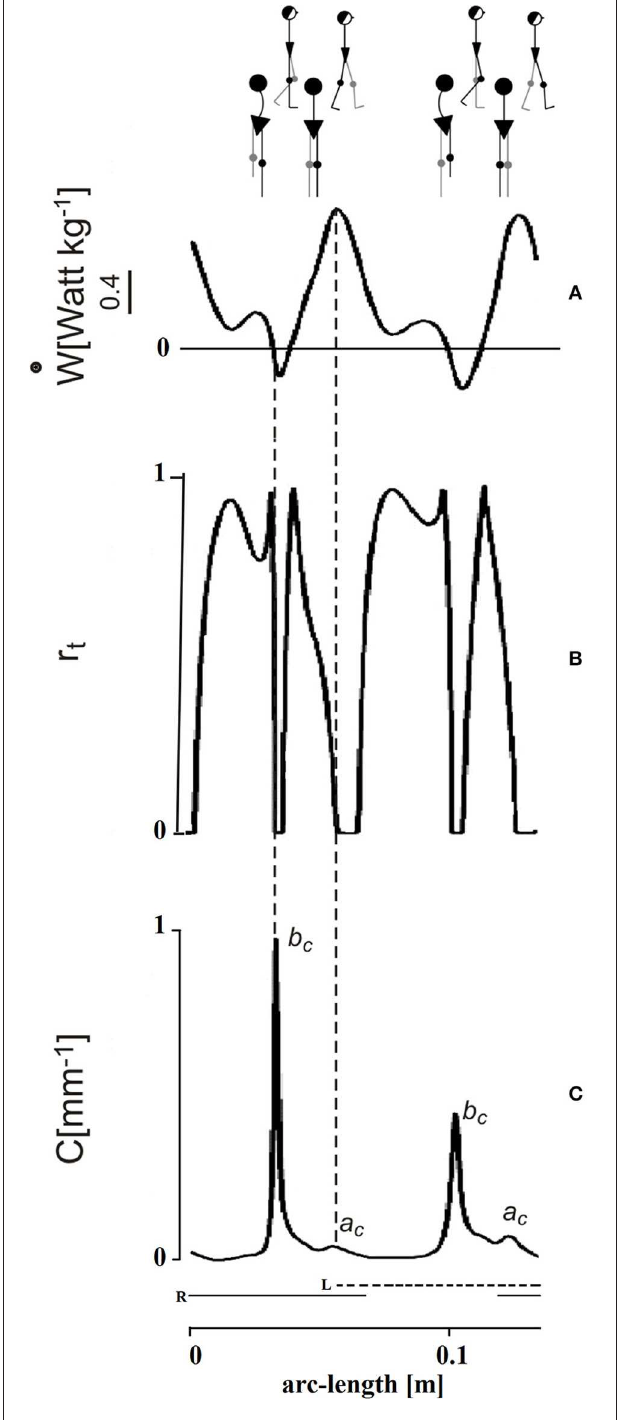
FIGURE 4 | Mechanical phenomena along the bow-tie trajectory of the center of mass (CoM). The tracings depict one stride performed by one subject walking at 0.96m s − 1 (see the human sketch on top). The abscissa gives distance (arc length of the CoM path). The time needed to cover the whole represented arc-length distance was 1.15s (not shown). Left (L) and right (R) foot stance is represented by the dashed and continuous horizontal bottom